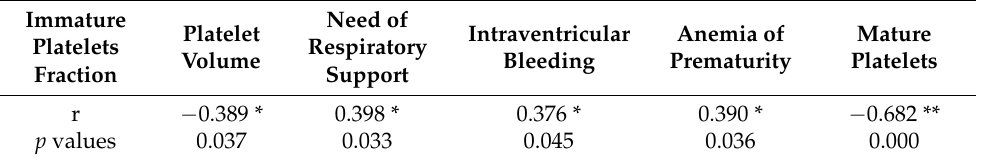
Table 4. Correlations between immature platelet fraction, clinicopathological aspects, and platelet parameters at preterm newborn